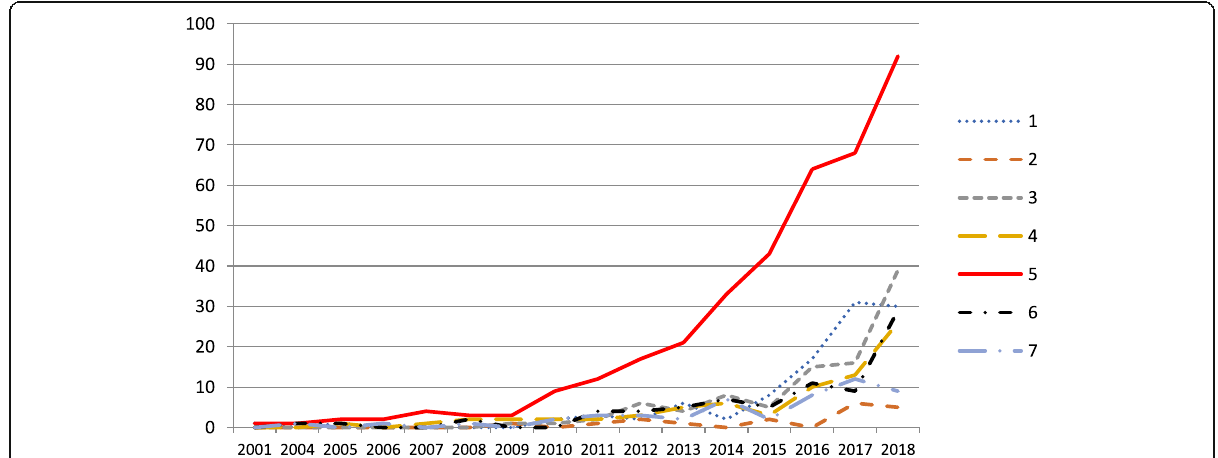
Fig. 12 Publication distributions in terms of research topics over the years